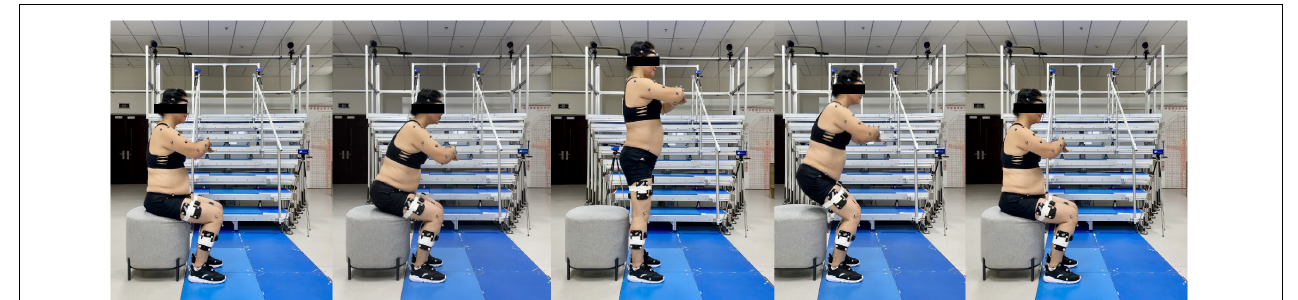
FIGURE 3 | The 30-s Chair Stand Test (30sCST).